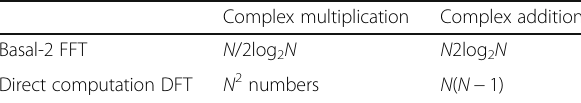
Table 1 Comparison of the computational quantities of basal-2 FFT and direct computation